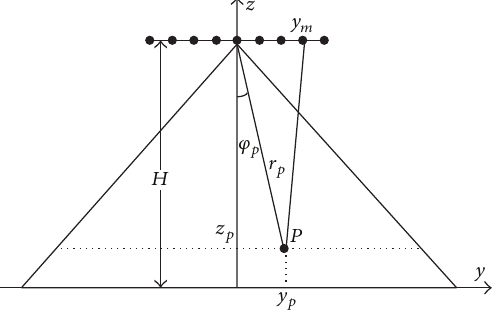
Figure 4: Geometry relations in cross track-height